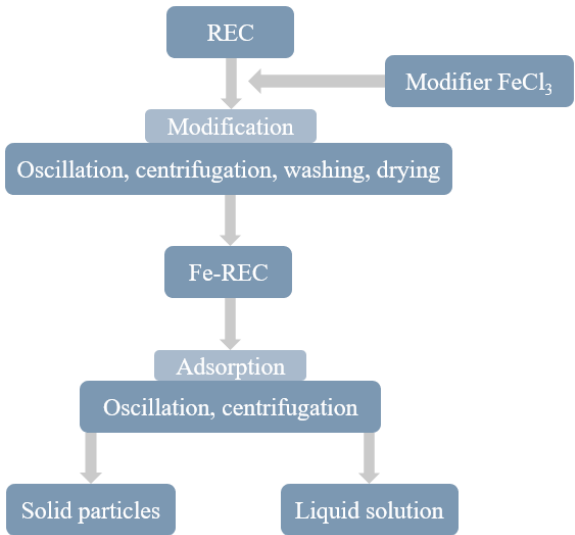
Figure 2. Schematic diagram of the procedure of modification and adsorption.